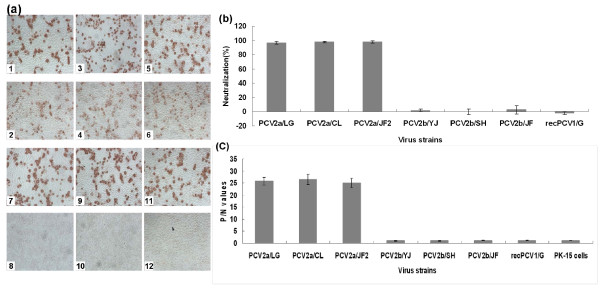
Reactivity of six PCV2 isolates with mAb 8E4 by the IPMA, serum neutralization assay and capture ELISA. (a) IPMA reactivity of PK-15 cells inoculated with PCV2a/LG (1 and 2), PCV2a/CL (3 and 4), PCV2a/JF2 (5 and 6), PCV2b/YJ (7 and 8), PCV2b/SH (9 and 10) and PCV2b/JF (11 and 12), against PCV2-positive serum and mAb 8E4. Odd numbers represent PCV2-positive serum, whereas even numbers show mAb 8E4. (b) The neutralizing activity of mAb 8E4 was expressed as the percentage reduction in the number of infected cells in comparison with negative control. A mean neutralizing activity of > 50% was considered to represent neutralization. Error bars represent the standard deviations. (c) For the capture ELISA, cultures of six PCV2 isolates, recPCV1/G and PK-15 cells were tested with HRP-conjugated 8E4. P/N > 2.1 was regarded as a positive result. Error bars represent the standard deviations.